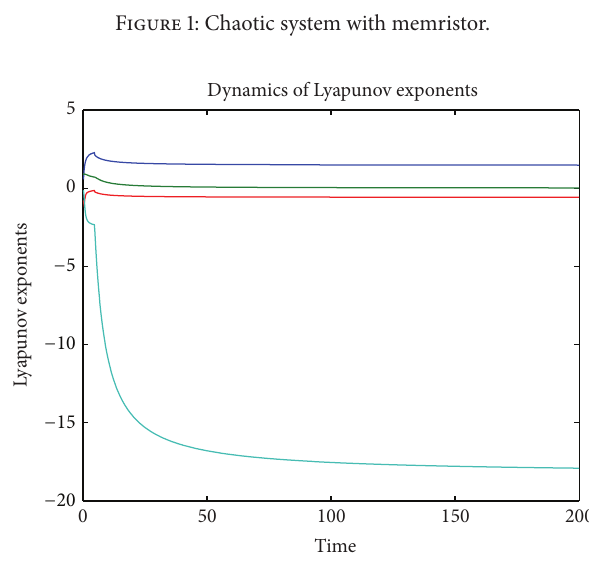
Figure 2: The Lyapunov